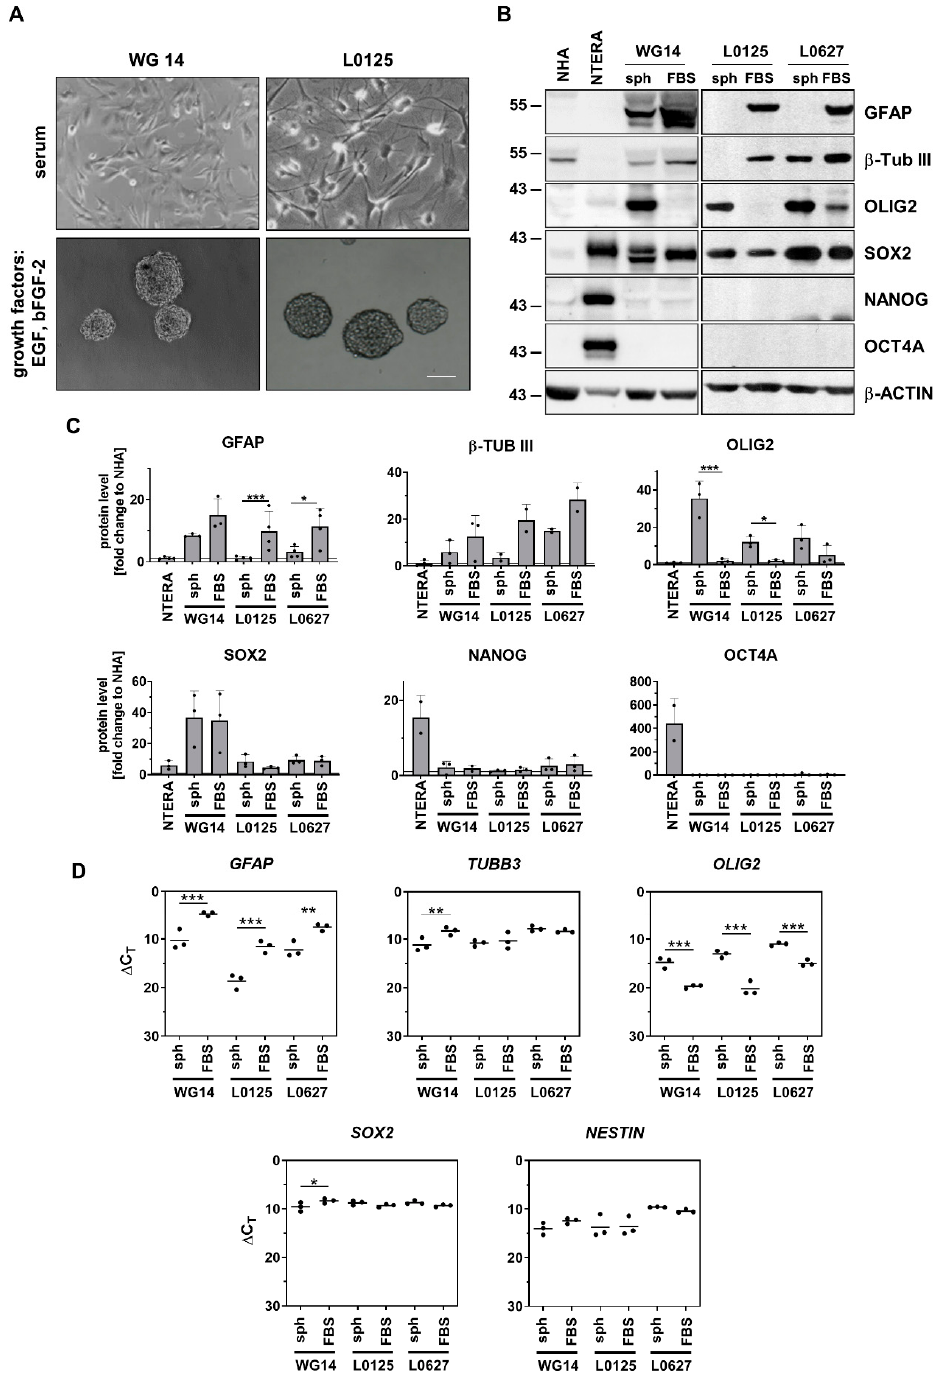
Figure 3. Characterization of stemness properties of GBM-derived sphere and adherent cell cultures. ( A ) Morphology of WG14 and L0125 cells in the presence of serum containing media (marked as FBS) or in the growth factors containing media (marked as sph). L0125 serves as a control cell line with stemness properties. ( B ) Representative immunoblots showing levels of GFAP, β -TUB III (dif-